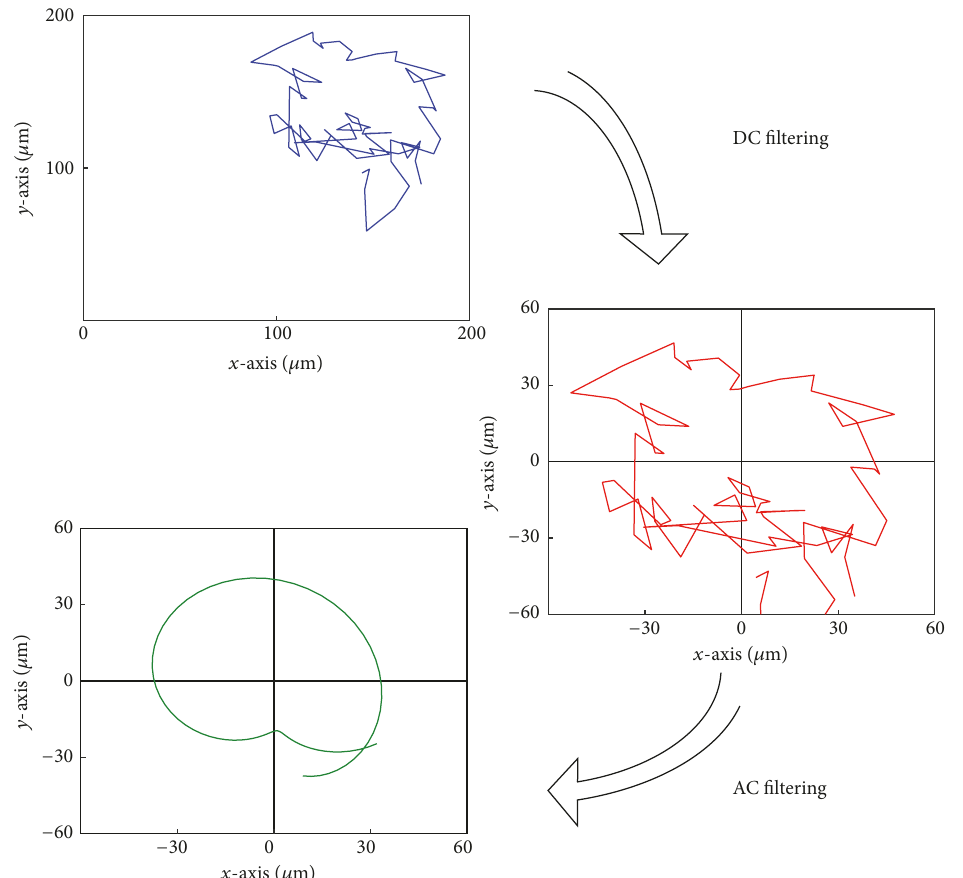
Figure 2: Orbit curve formation for different inputs